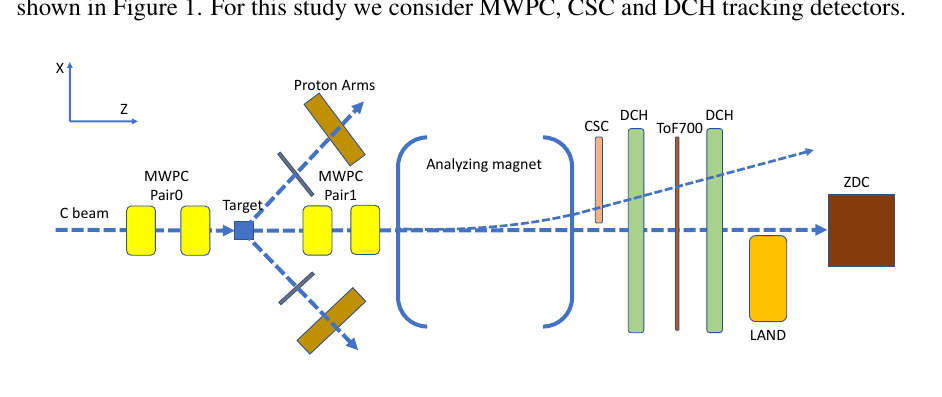
Figure 1. Schematic view of the SRC at BM@N experimental